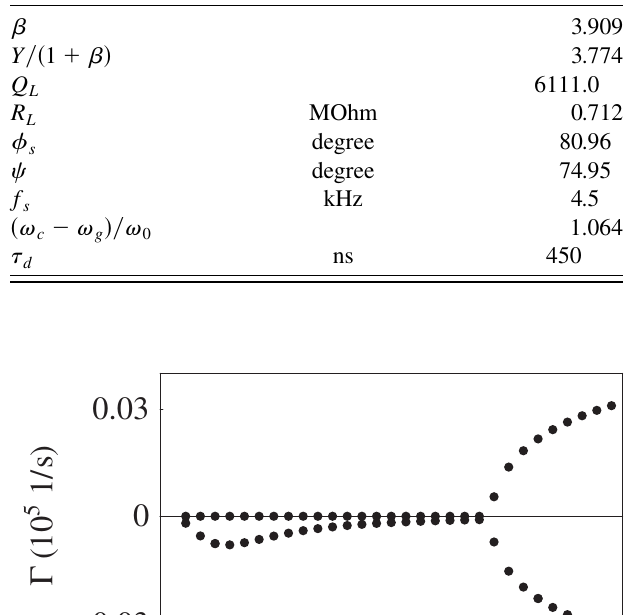
TABLE II. The steady-state parameters.